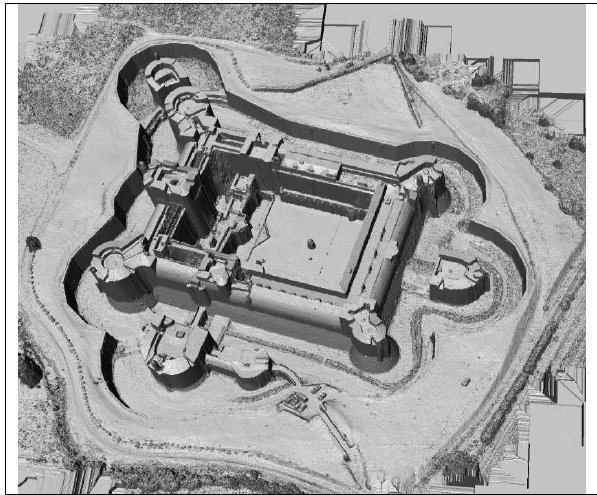
Figure 3. .Modelisation of forteresse de Salse.